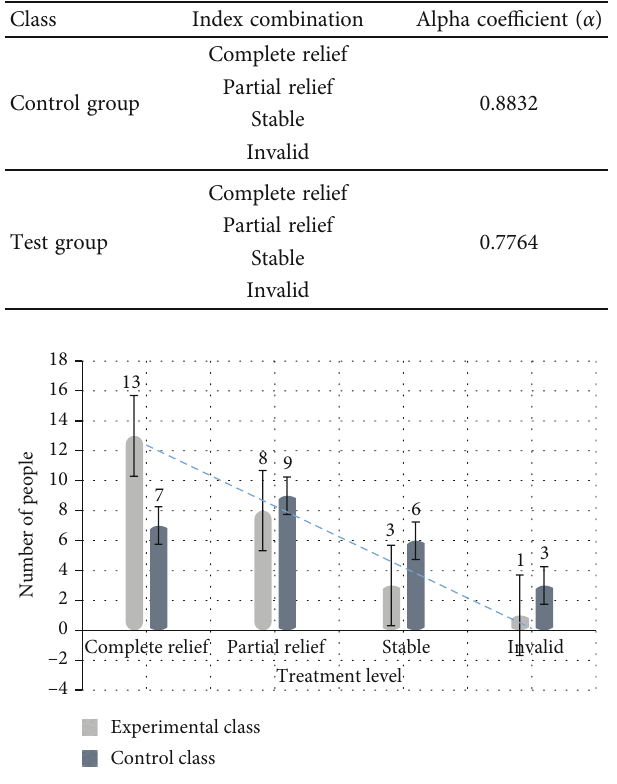
Table 1: Summary table of reliability test results.